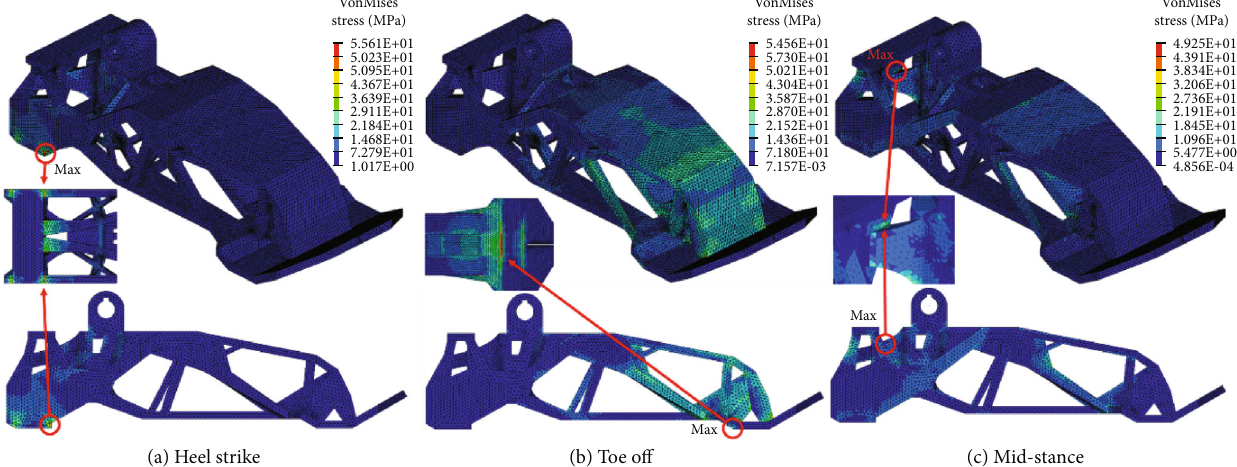
Figure 14: Results of the FE analysis of the foot structure. Table 2: Peak stresses of each walking phase. Walking phase Max stress Yield